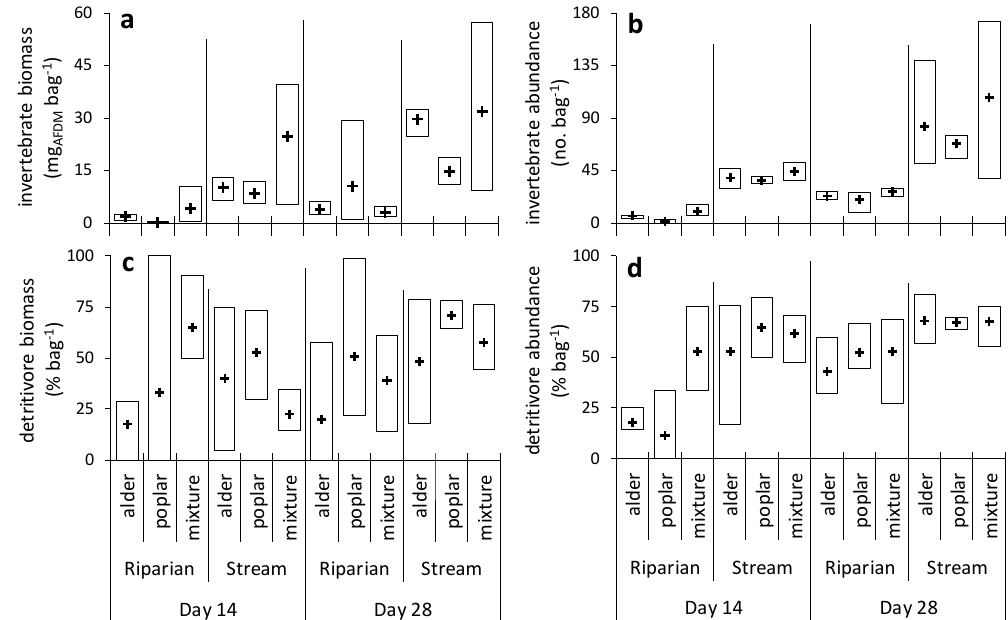
Figure 2. ( a ) Total invertebrate biomass and ( b ) abundance, ( c ) percentage detritivore biomass and ( d ) abundance colonizing leaves of alder, poplar and mixture decomposing in the stream and at the riparian zone of Ribeira do Botão. Values are ranges (boxes) and means ( + ) of n=3.